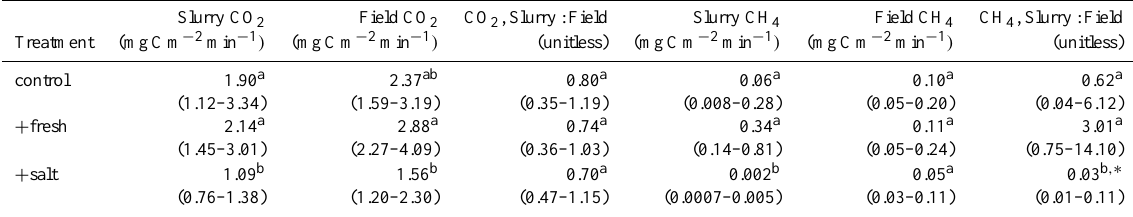
Table 1. Comparison of areal fluxes (mgCm − 2 min − 1 ) of CO 2 and CH 4 based on (i) production rates measured in anaerobic slurry bottles and (ii) emission rates measured in the field using dark ecosystem metabolism chambers. The field flux measurements were made in Nov 2011, roughly two weeks prior to the collection of soil that was used in the slurry experiments (Neubauer, 2013b). Values are means, with ranges shown in parentheses ( n = 5). Rates and ratios were log 10 transformed, averaged by treatment, and then back-transformed for presentation. Within a column, values with the same superscripted letters are not significantly different from each other (one-way ANOVA of log 10 transformed data, followed by Tukey’s HSD multiple comparison test). An asterisk indicates that a slurry:field flux ratio was significantly different from 1.0 (Student’s t